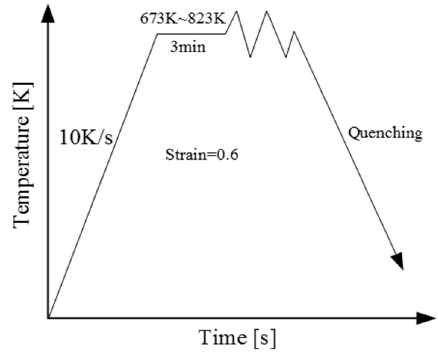
Figure 2. A schematic diagram of the temperature history in hot compression test.